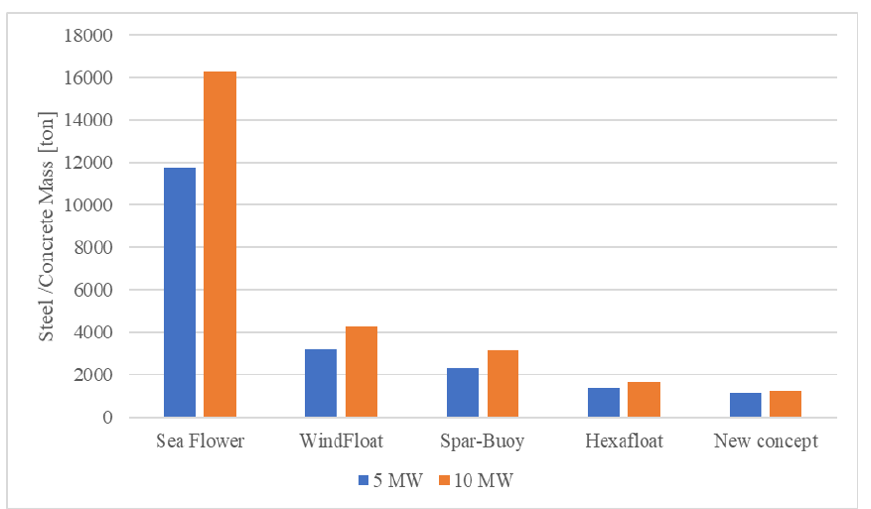
Figure 11. Comparison between the different concepts in terms of material cost.